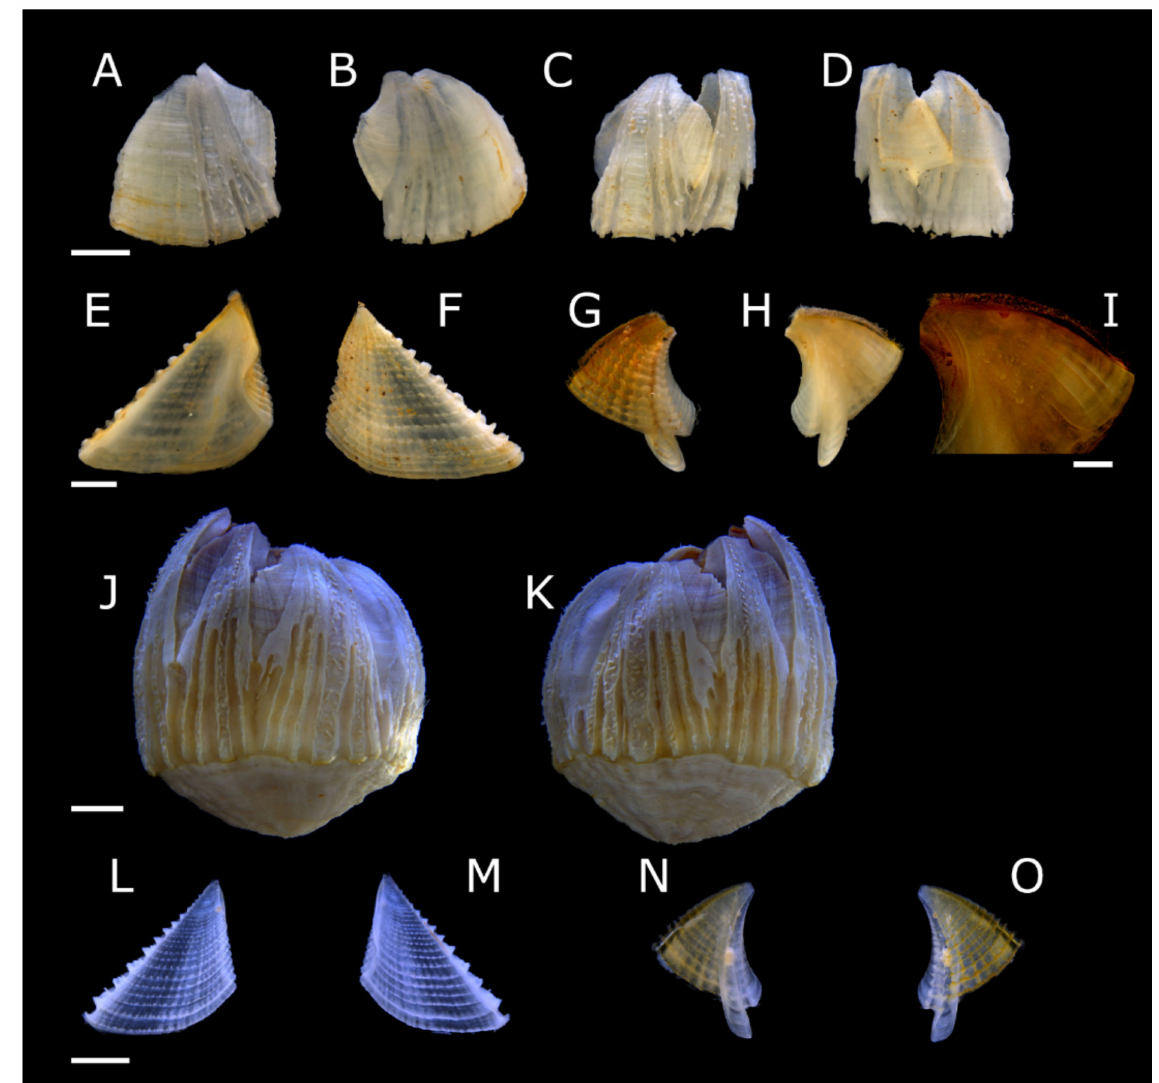
Figure 17. Pectinoacasta cancellorum (Hiro, 1931) shell and shell plates (A–I, Lectotype SMBL #149; J,K, WAM C55340; L–O, WAM C55305): ( A , B ) external and internal view of rostrum; ( C , D ) external and internal view of articulated right lateral and carinolateral (radius broken) plates; ( E , F ) internal and external view of left scutum; ( G , H ) external and internal view of left tergum; ( I ) close up of depressor muscle crests on right tergum; ( J , K ) left and right views, respectively, of whole specimen; ( L , M ) external and internal views of right scutum; ( N , O ) internal and external views of right tergum. Scale bars: A–D, J,K = 2 mm, E–H, L–O = 1 mm; I = 0.5